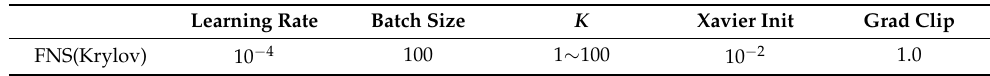
Table A5. Training hyperparameters for Helmholtz equation.